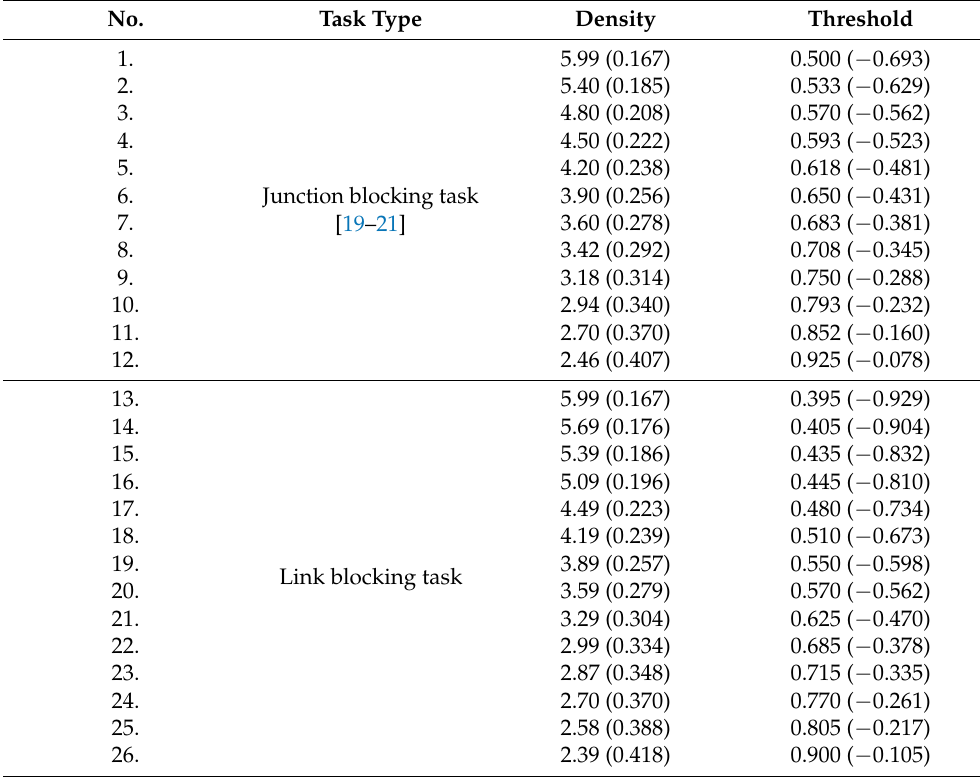
Table 1. Values of percolation thresholds for planar networks with an accidental